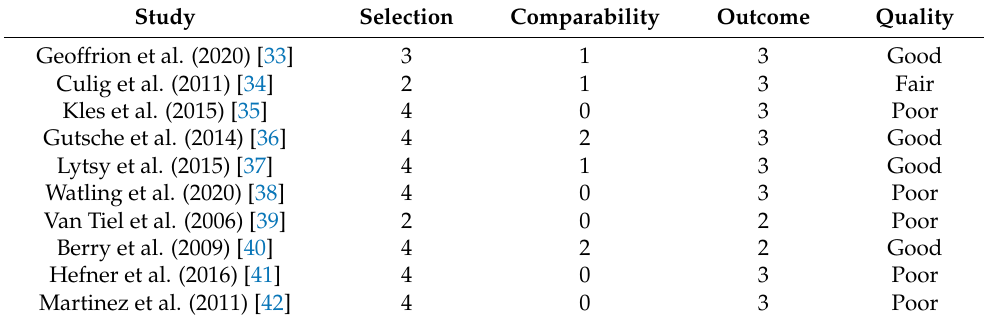
Table 2. Risk of bias assessment.